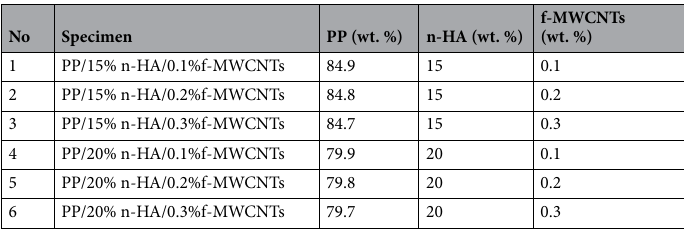
Table 3. Specimen